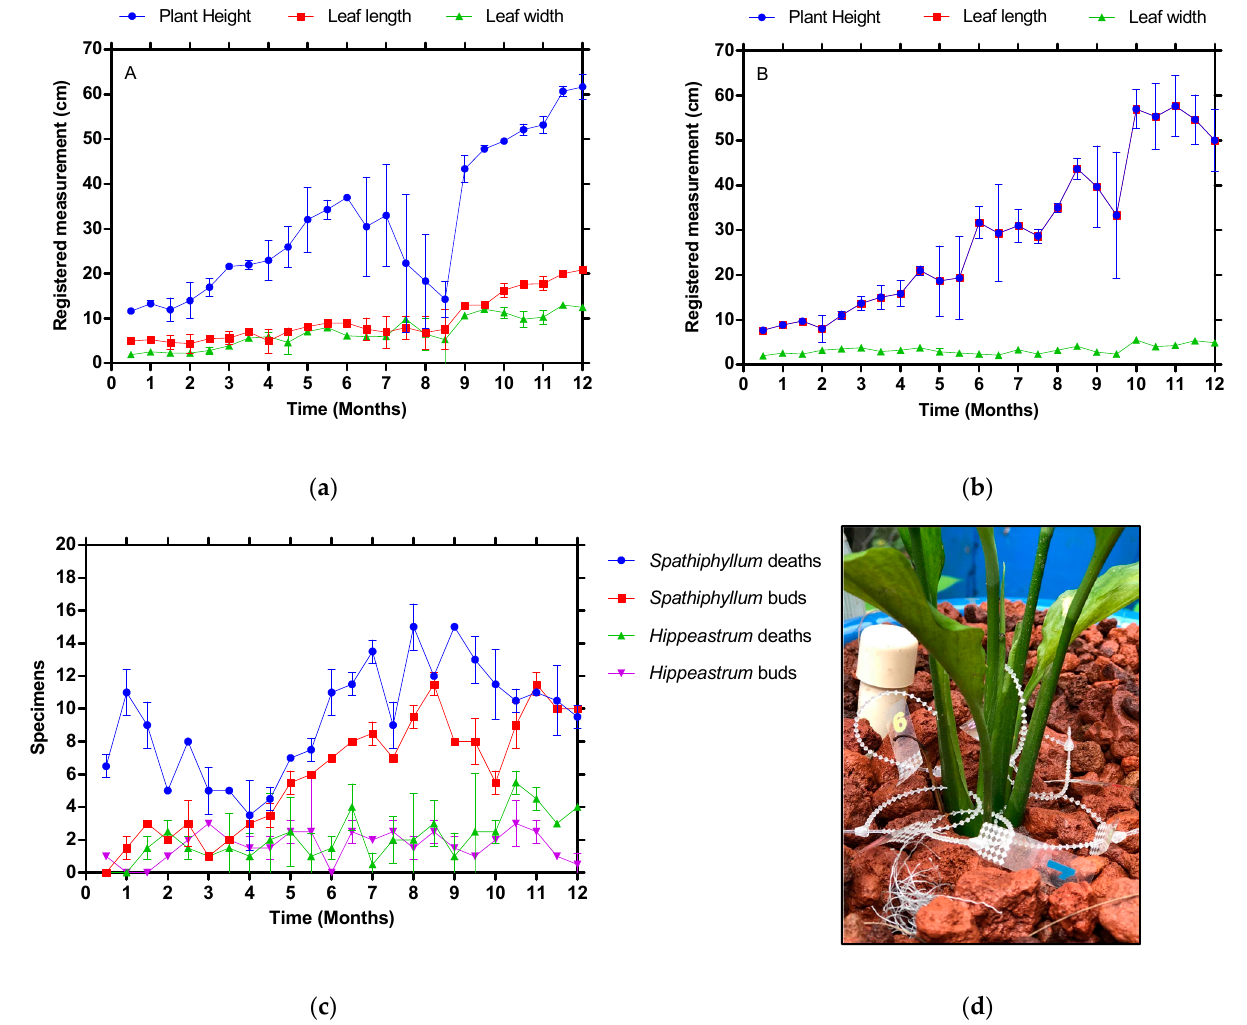
Figure 8. Plant development in the CW: ( a ) Spathiphyllum ; ( b ) Hippeastrum ; ( c ) deaths and buds; ( d ) ID monitoring.